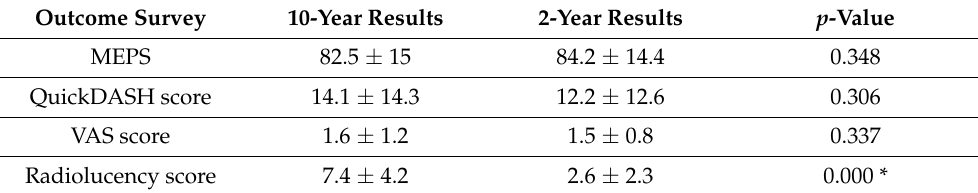
Table 1. Comparison of clinical outcomes and radiolucency